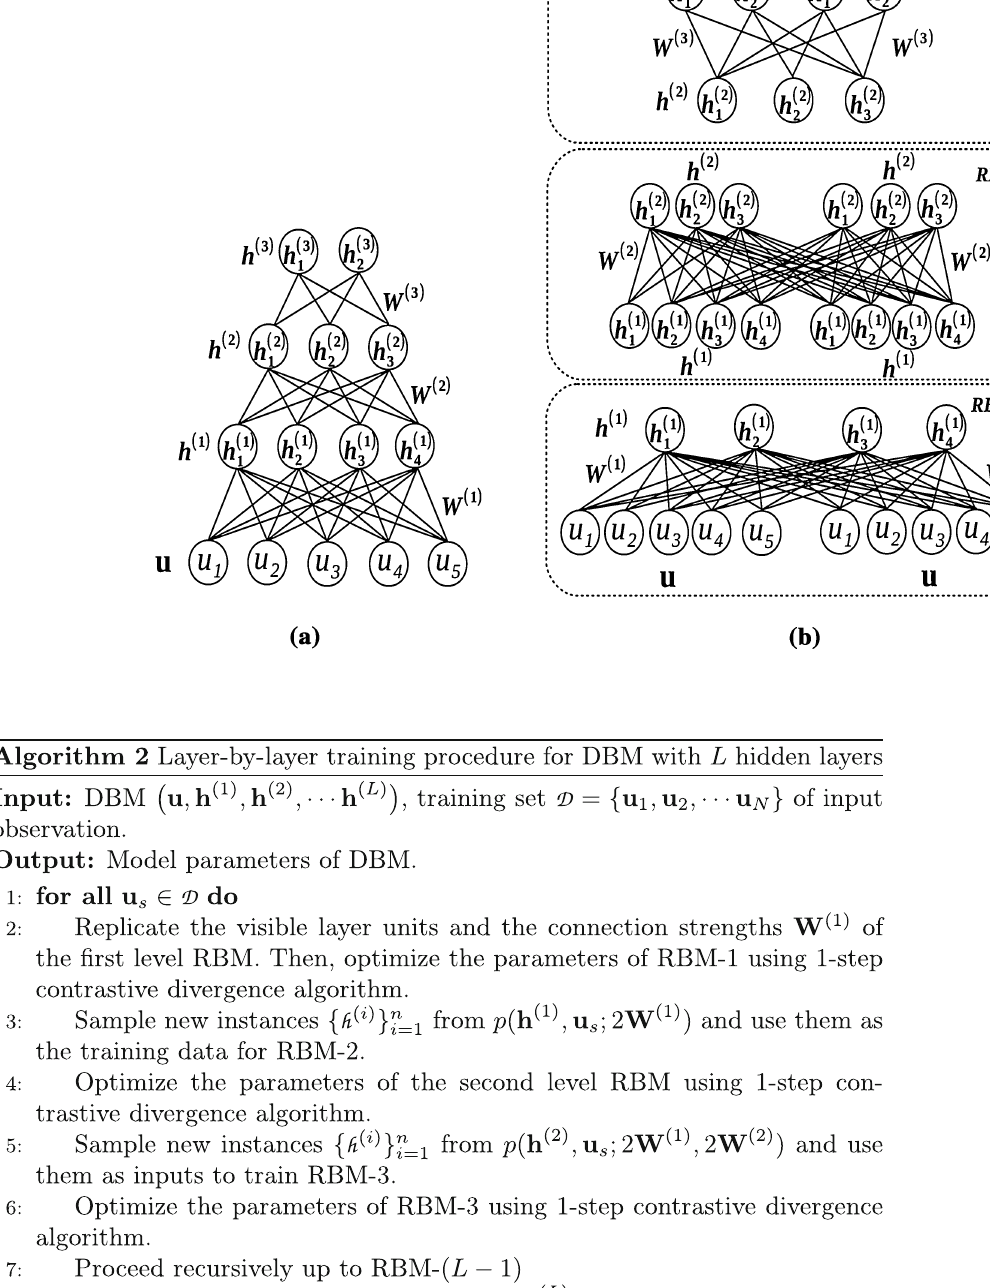
Fig. 5 Greedy learning strategy for DBM with three hidden layers